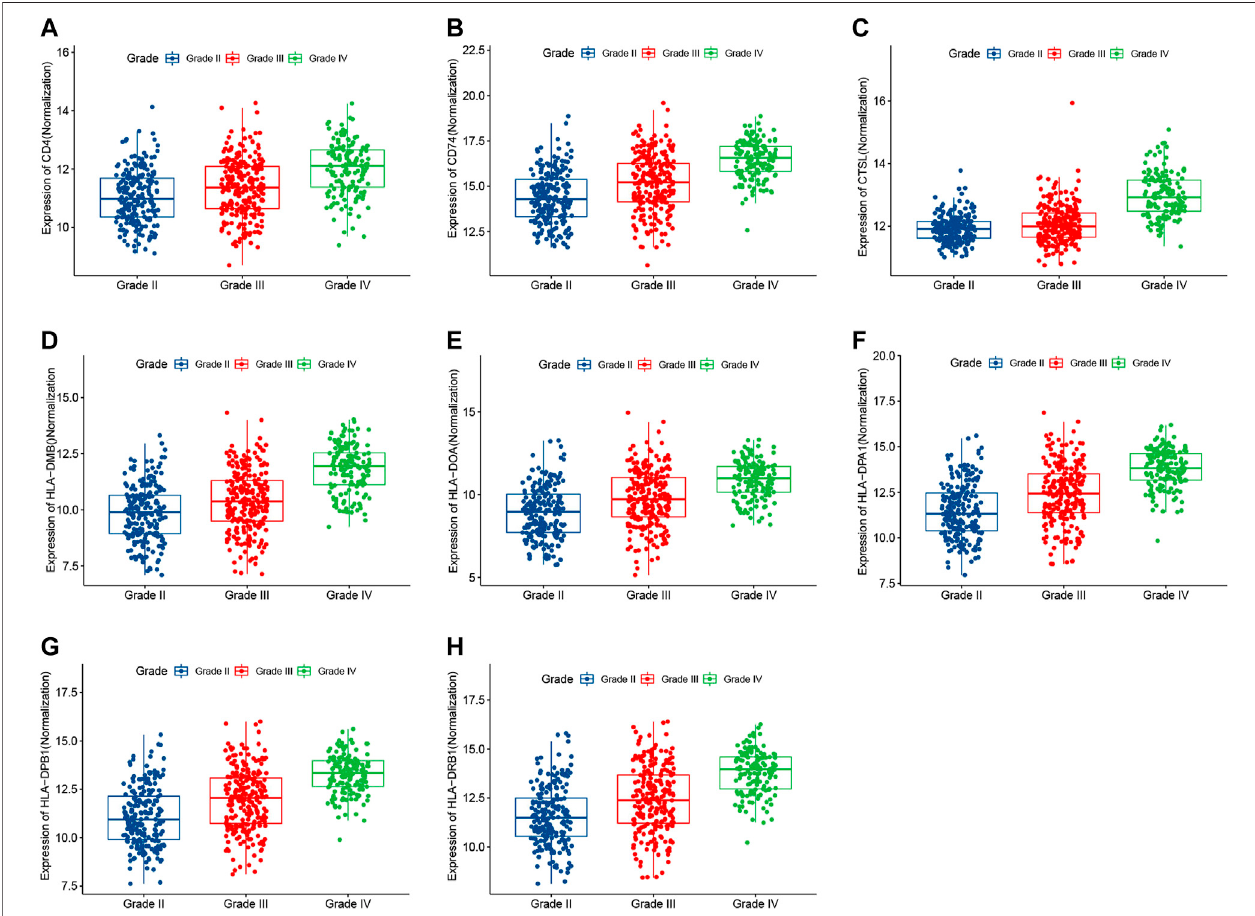
FIGURE 7 | The expression levels of target genes were correlated with more advanced tumor grades in TCGA (Kruskal – Wallis nonparametric test, p < .0001).